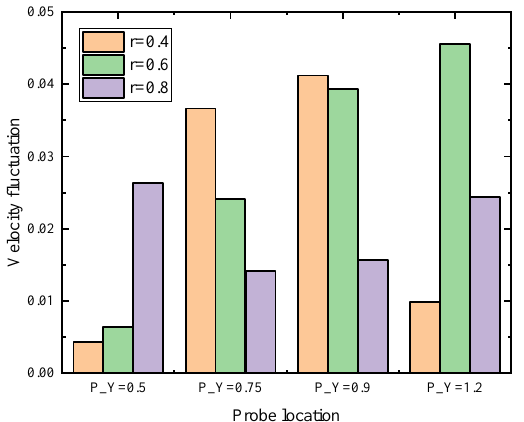
Figure 8. Magnitude of velocity fluctuation under different bubble distribution, which means bubble swarm is limited with different spatial concentration characterized by distribution factor, r = L/L 0 .